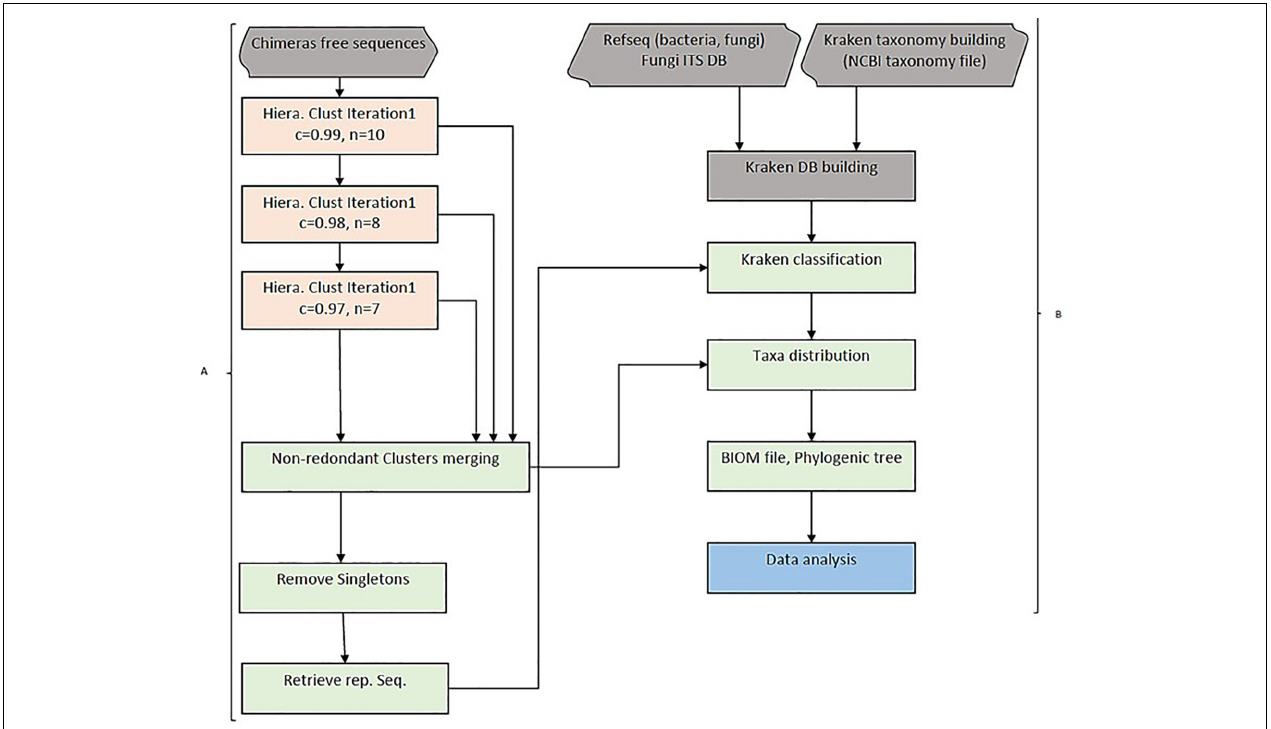
FIGURE 1 | HCK workflow diagram. (A) Hierarchical clustering with three iterations. Chimaeras free sequences are results of pipeline step 1, including raw reads trimming, merging (forward and reverse reads) and ABAA filtering. Sequences are combined into one single fasta file and clustered using a hierarchical clustering approach in step 2. All clusters are then merged into one single non-redundant clusters and got rid of singletons sequences. HCK retrieves representative sequences from each cluster for amplicons’ classification, the second part of the pipeline (step 3). (B) Classification uses Lowest Common Ancestor (LCA) taxonomical assignment implemented in Kraken to classify representative sequences and taxonomy reported to each cluster, and a final BIOM file can be generated for downstream analysis (Steps 4 and